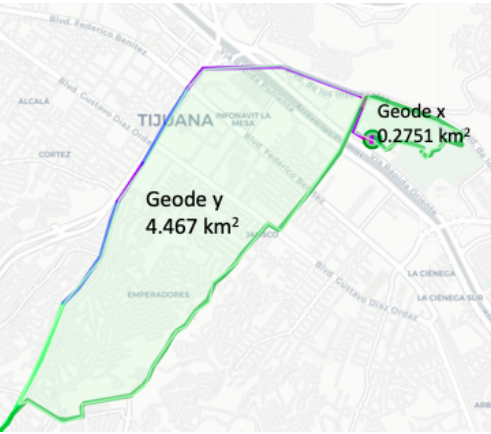
Figure 6. proposed model from qualitative